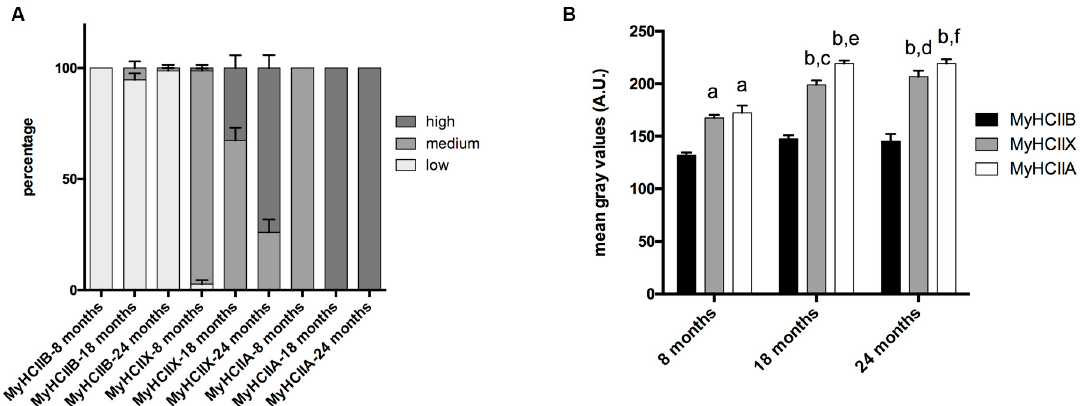
Figure 3. Fiber-type-dependent SDH activity during age progression. ( A ) The qualitative analysis indicates that type-IIB fibers display no difference in the three age groups, and type-IIX and -IIA fibers switch from medium activity to high activity during age progression. ( B ) The quantitative analysis of SDH activity indicates differences depending on fiber type and age (a, significantly different from age matched type-IIB fibers, p < 0.001; b, significantly different from age-matched type-IIB fibers, p < 0.0001; c, significantly different from eight-month type-IIX fibers, p < 0.01; d, significantly different from eight-month type-IIX fibers, p < 0.001; e, significantly different from eight month-old type-IIA fibers, p < 0.0001; f, significantly different from eight-month-old type-IIA fibers, p < 0.0001). In the Y-axis, the mean gray values in arbitrary units (A.U.) are reported. Data are expressed as means ± SEM.